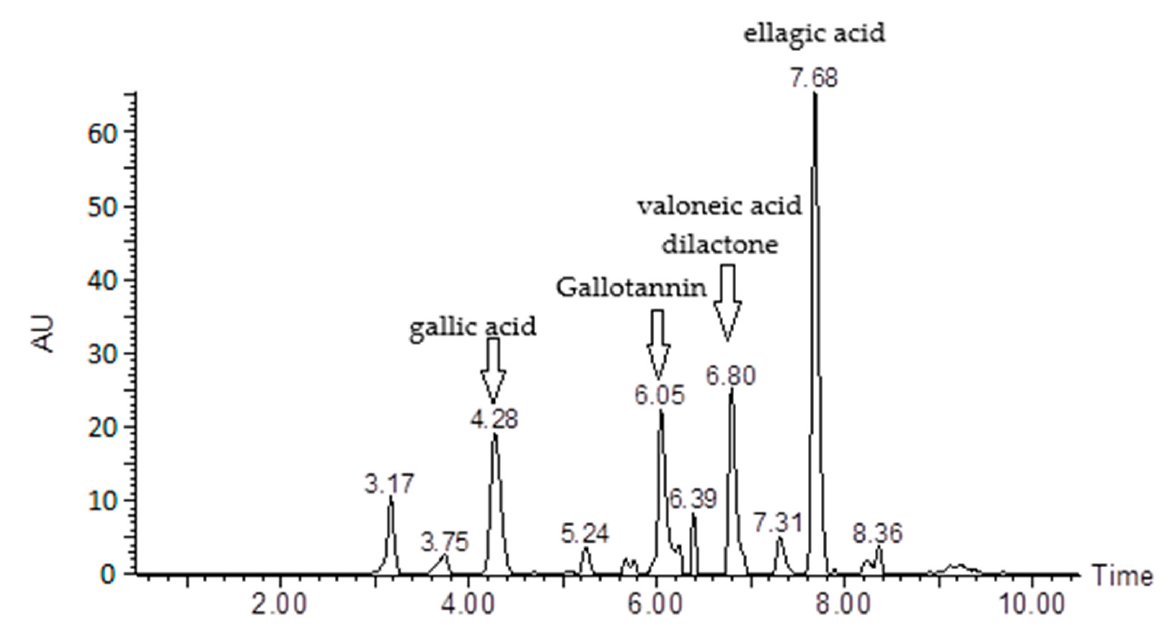
Figure 1. HPLC-DAD chromatogram of hydroalcoholic extract of Jucá. AU: absorbance. Numbers within the compound name indicate the retention time (min). The quanti fi cation of the compounds identi fi ed 78.1% of the constituents in the sample, with ellagic acid being the major compound at 34.27% (Table 1). Table 1. Chemical composition of hydroalcoholic extract of Jucá. Table 2. In vitro results for antiplasmodial activity (IC 50 ) of Juc á hydroalcoholic extract against